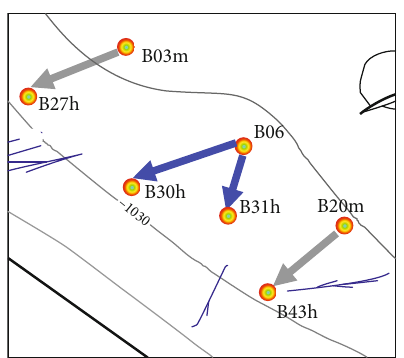
Figure 4: The schematic diagram of the B6 well group. The blue arrow represents the target study well group, and the gray arrow represents the nonstudy well group around the target